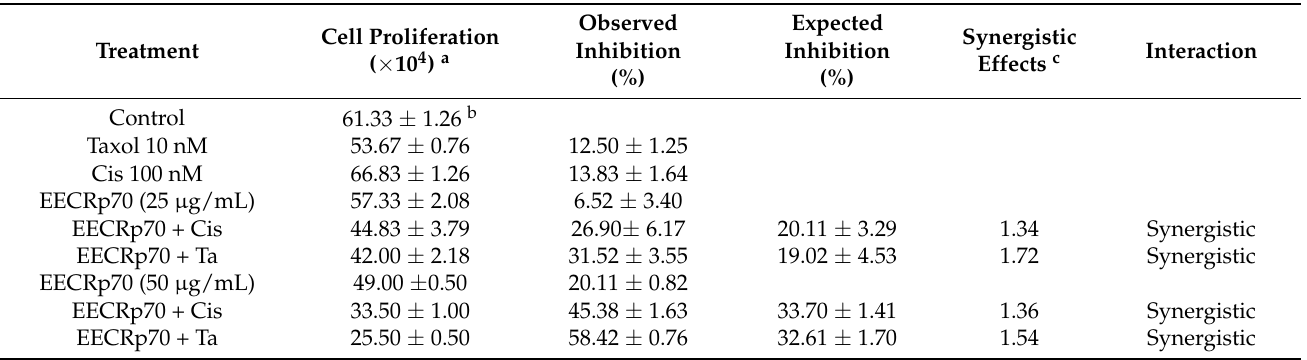
Table 2. Synergistic effects of antiproliferation of SCC25 cells between EECRp70 and taxol (Ta) or cisplatin (Cis) at 24 h